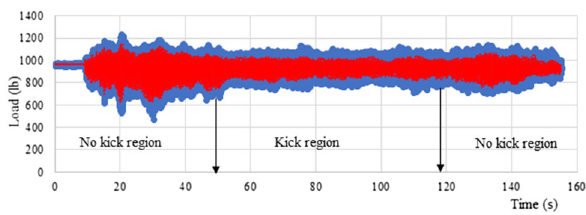
Fig. 6 Effects of gas kick on WOB for experimental Run_1